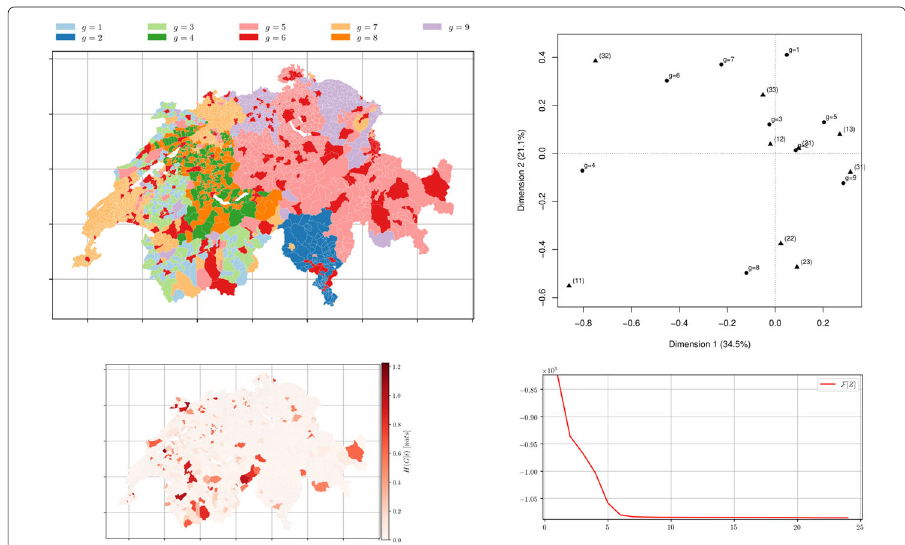
Fig. 13 Municipalitiessoftclusteringonallthetopics depicts the semi-supervised hard assignment obtained from the k-means performed over the therm-frequency distances with θ = 0.99 on the Z 0 for m = 9 groups using χ 2 distances D obtained from topic modelling with k = 9 after 24 iterations. Lefttop Hard membership. Leftbottom the conditional entropy of topics H ( R | i ) showing municipality-topic probability distribution uncertainty. Righttop CA bi-plot between Z ∞ ( • ) and the official classification ( (cid:2) ) with m = 9. Rightbottom The free-energy plot ( β = 30, α = 10)